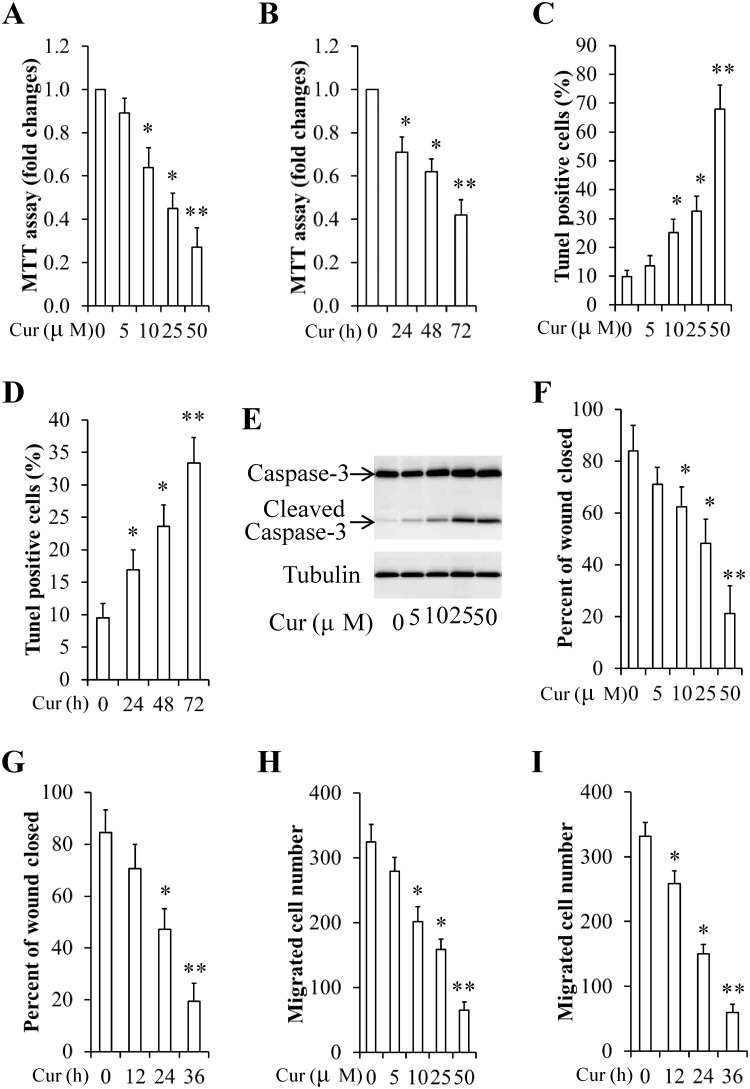
Effect of curcumin (Cur) on proliferation and migration of MDA-MB-231 cells.(A and B) Proliferation determined by MTT assay. (C and D) Cell apoptosis determined by TUNEL assay. (E) A representative western blot image of cleaved caspase-3. (F and G) Quantitative analysis of wound closure. (H and I) Mean values for the number of migrated cells counted in the closed areas. Data are means ± SEM. (n = 3).*p<0.05, ** p<0.01 vs DMSO control.